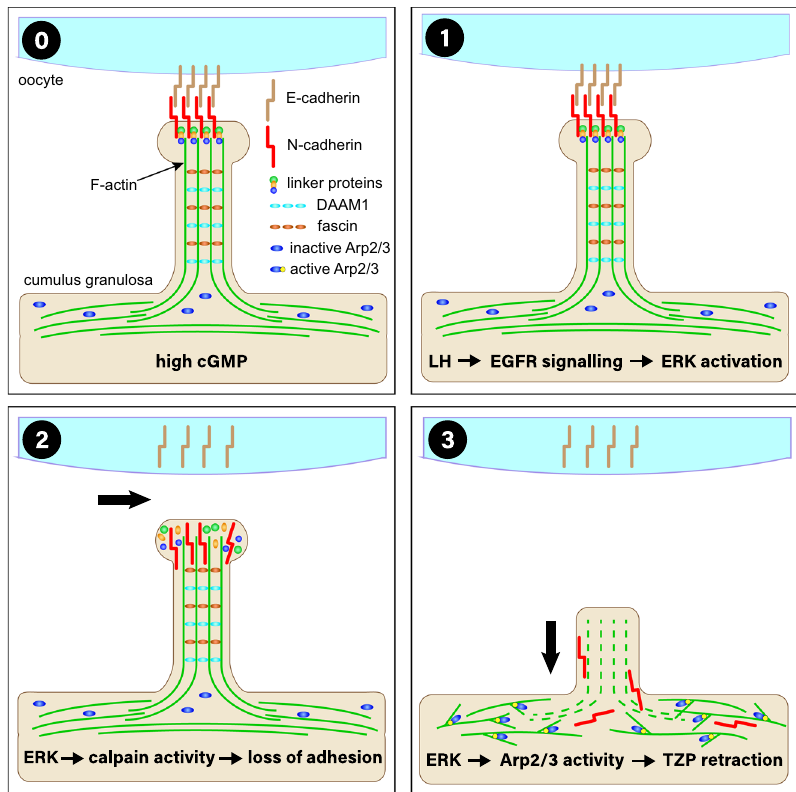
Fig. 7 Model of TZP retraction. In antral follicles (stage 0), TZPs projecting from the cumulus granulosa cells to the oocyte contain a backbone of linear F- actin together with the formin, DAAM1, and fascin 15 . N-cadherin (cumulus granulosa) and E-cadherin (oocyte) mediate adhesion between the two cell types. cGMP in the granulosa cells may maintain the TZPs. At the time of ovulation (stage 1), binding of LH to its receptor in the mural granulosa cells triggers release of EGFR ligands, which in turn activates ERK MAP kinase. Active ERK activates calpain (stage 2), which degrades proteins required to maintain N-cadherin at the cumulus granulosa cell membrane, thereby permanently breaking germ-soma contact. Increased activity of the branched chain actin nucleator complex, Arp2/3, which may also be regulated by ERK MAP kinase, reorganizes the actin cytoskeleton (stage 3) leading to a retraction of the TZPs into the granulosa cell